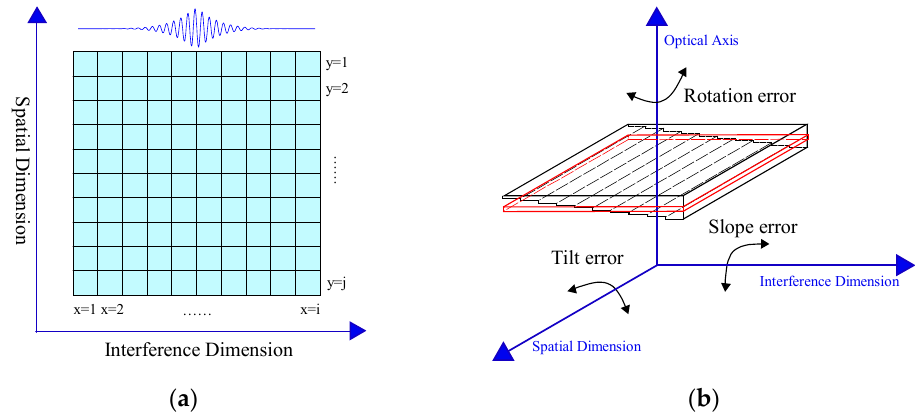
Figure 2. ( a ) Schematic diagram of interferogram measured by SIFTS. ( b ) Schematic diagram of the error classification in interference core.